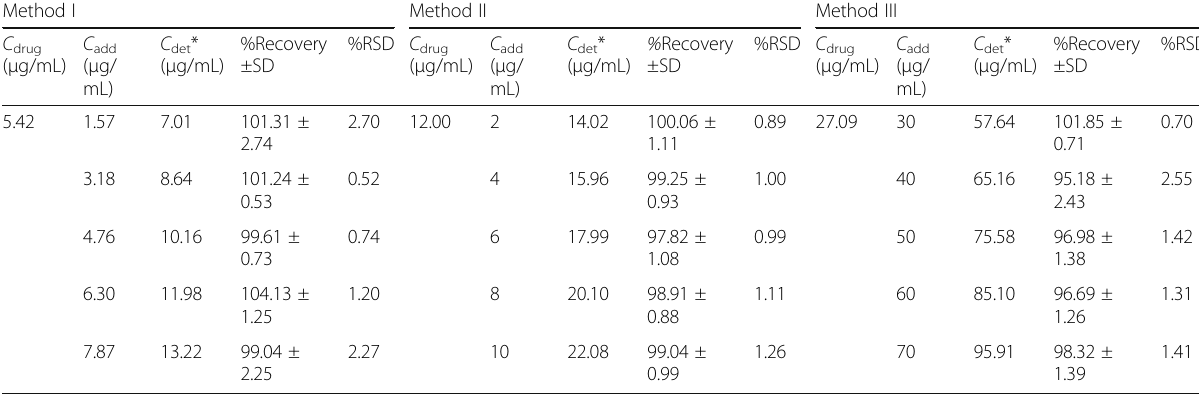
Table 4 Results of the recovery studies using standard addition method Method I Method II Method III